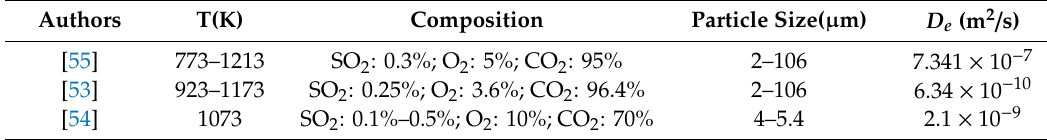
Table 5. Table of e ff ective di ff usivities, measured for di ff erent systems at atmosphere